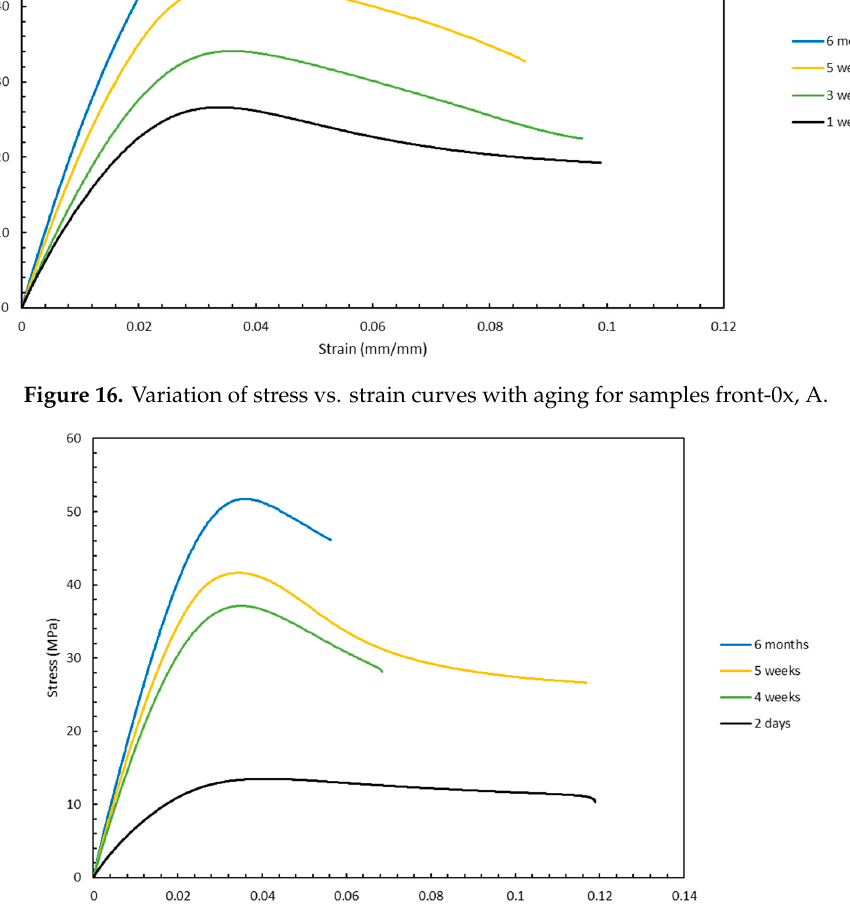
Figure 17. Variation of stress vs. strain curves with aging for sample front-60z, O.